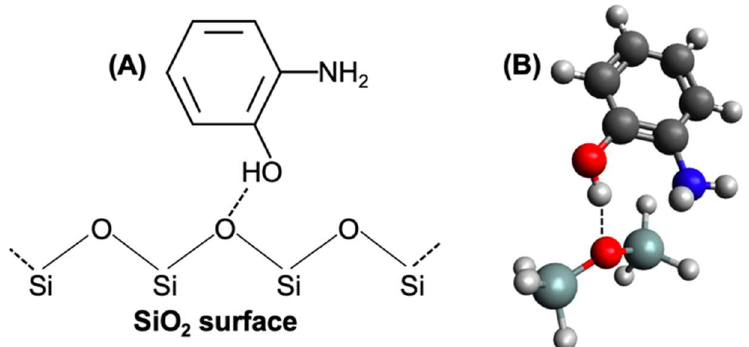
Figure 5. ( A ) Schematic representation of o-aminophenol H-binding to a SiO 2 surface. ( B ) A molecular model of aminophenol binding to disiloxane was simulated for this analysis. In ( B ), dark grey, light grey, red, dark blue, and teal circles represent carbon, hydrogen, oxygen, nitrogen, and silicon atoms, respectively.